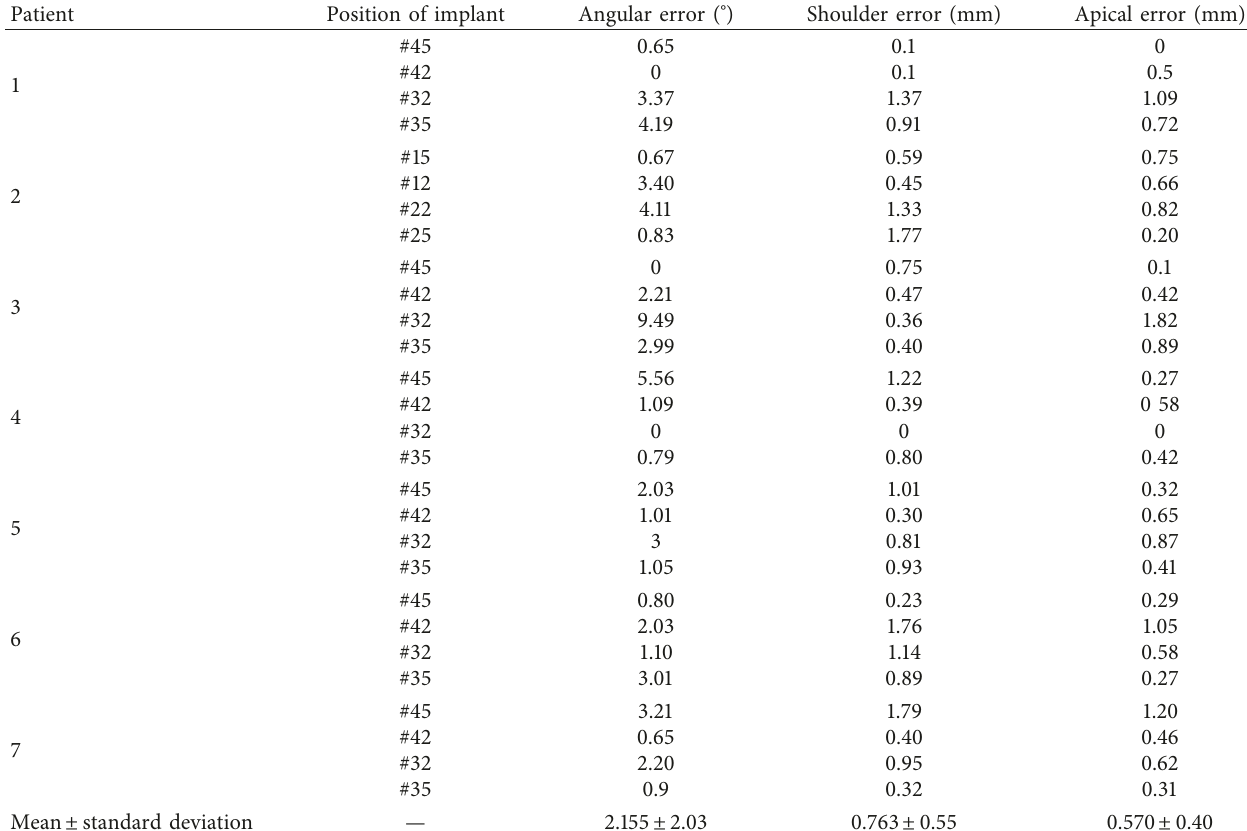
Figure 4: (a) Preop clinical presentation. Partially edentulous with high mobility of the teeth and gummy smile. (b) Immediate postop with provisional prosthesis. With ostectomy of the maxilla we correct the defect of the patient’s smile. Table 1: Accuracy: angular and distance